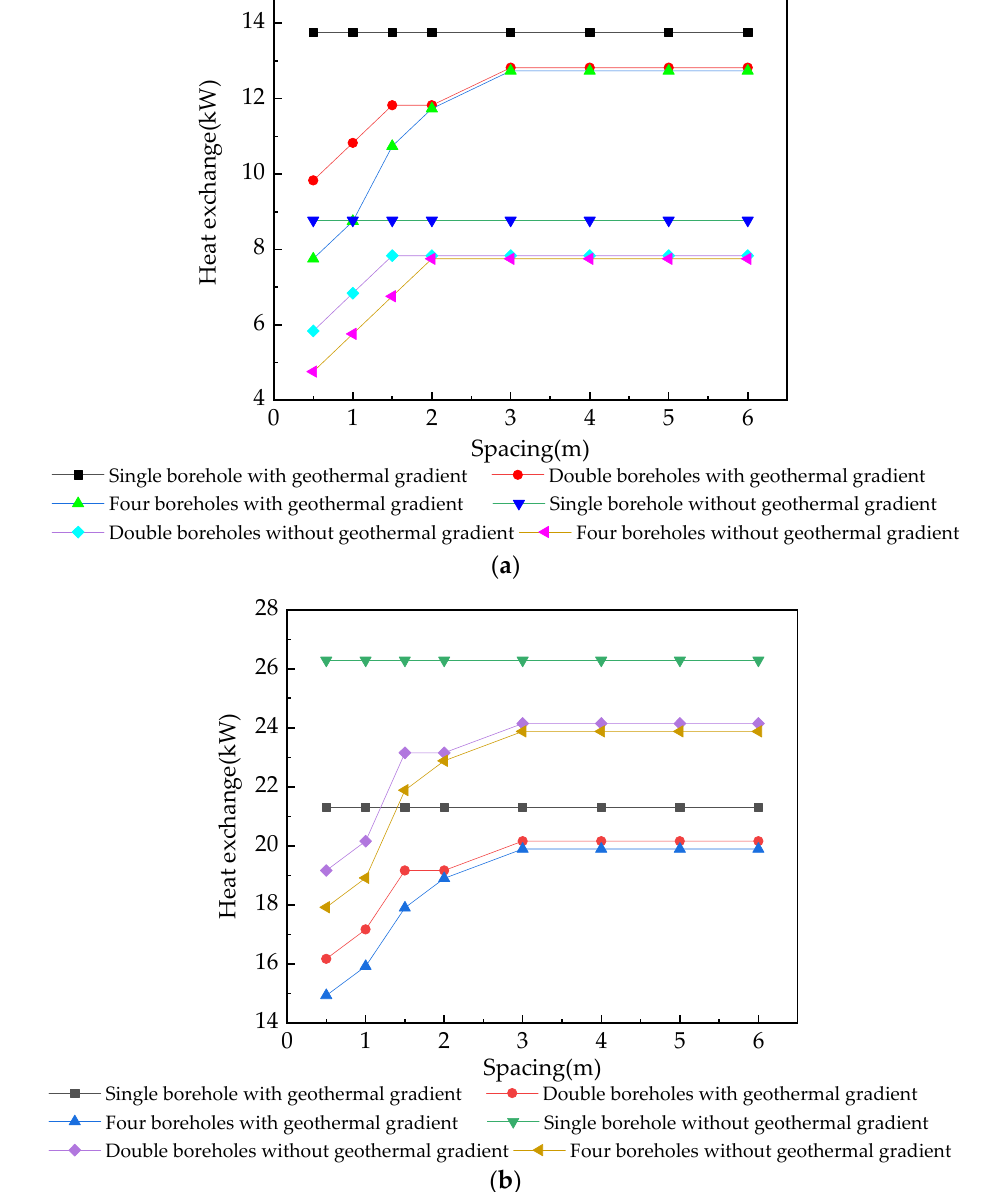
Figure 5. Changes in heat exchange. ( a ) Heat exchange in winter. ( b ) Heat exchange in summer.